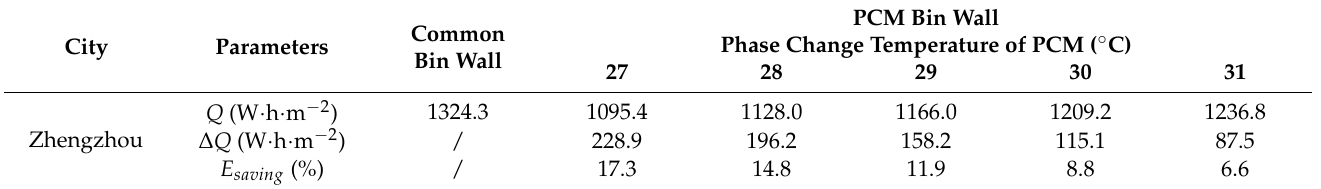
Table 3. Weekly heat gain and energy saving results with different T m for warm grain storage region.